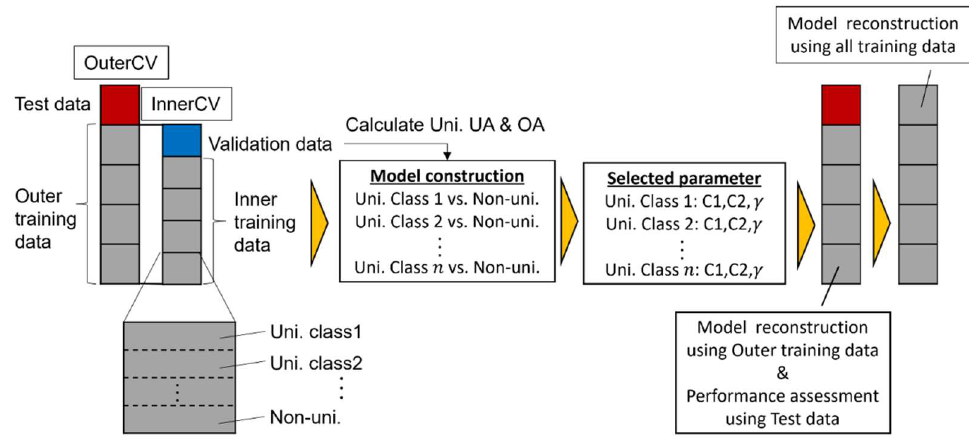
Figure 2. Flow of nested cross-validation.